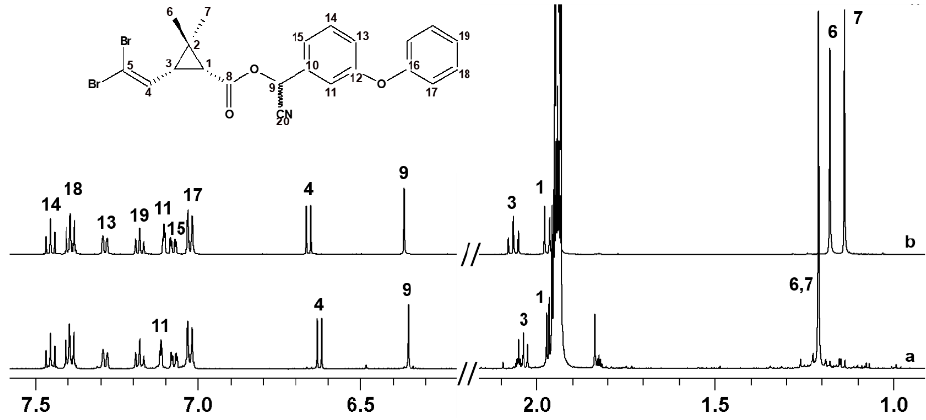
Figure 2. 1 H NMR (600 MHz, ACN-d 3 /H 2 O 80:20 m/m, 300 K) spectra of ( a ) i -DLM and ( b ) a -DLM.